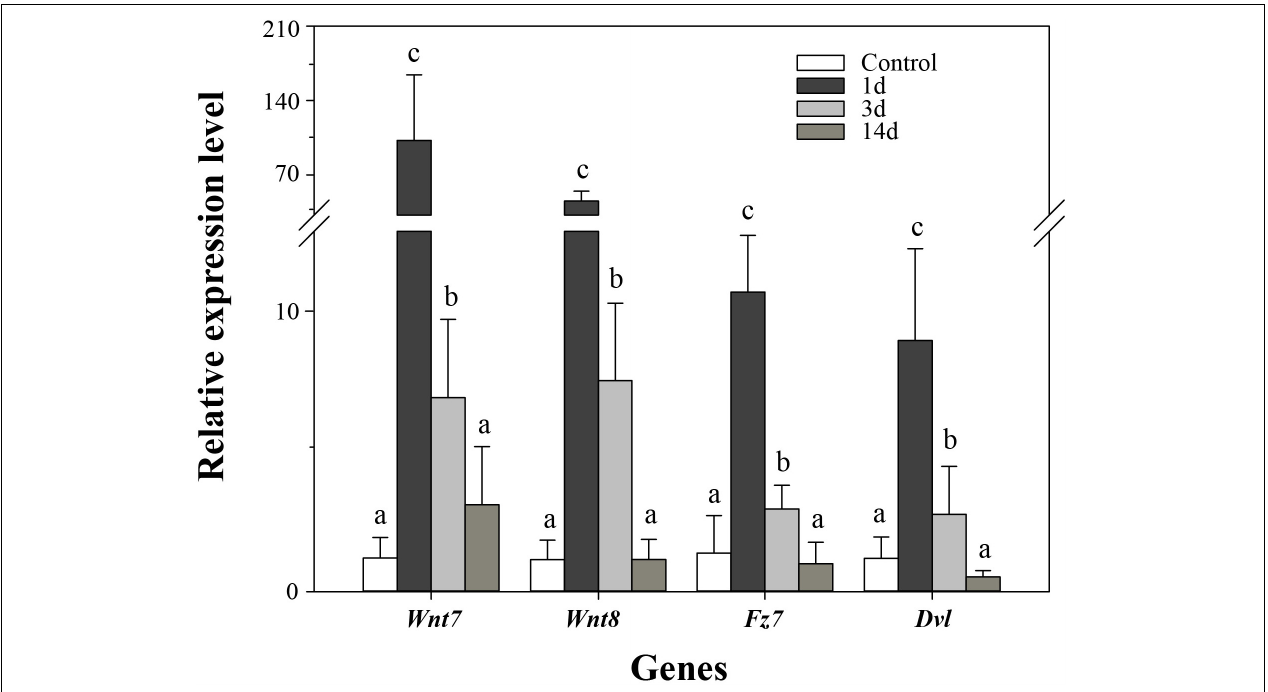
FIGURE 6 | Real-time PCR analysis of four genes during intestinal regeneration. Normal tissues of the intestine were treated as the control group. The values were normalized against NADH. Data are the mean ± standard deviation of the triplicate experiments. Different lowercase letters indicate significant differences ( p < 0.05).